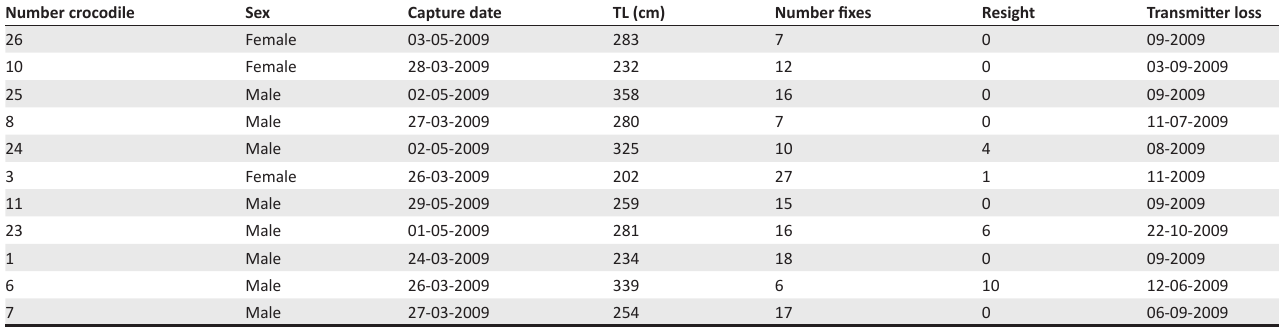
TABLE 1: Radio and mark-resight occurrences of 10 Nile crocodiles (202 cm – 358 cm total length) over a 7-month period (March 2009 – November 2009) in Ndumo Game Reserve. Number crocodile